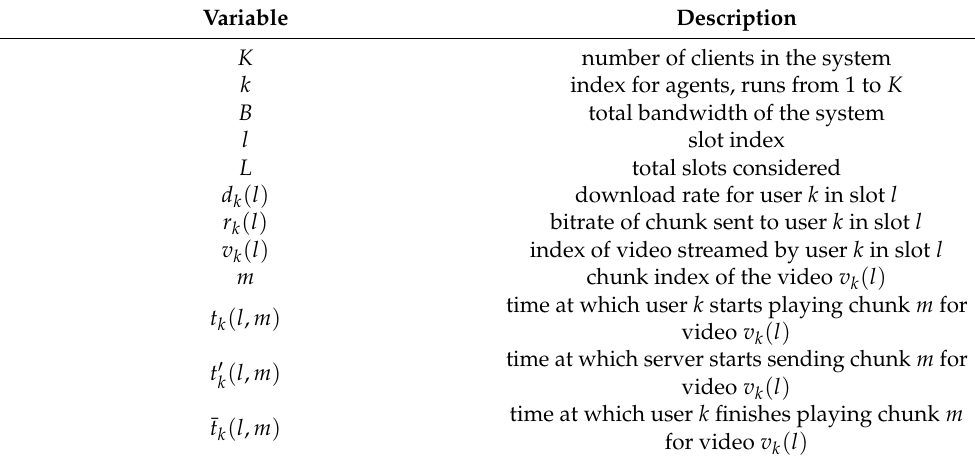
Table 1. List of the key variables used in this paper. Variable